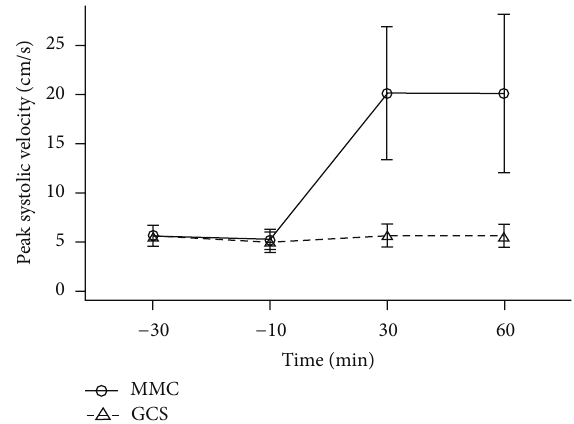
Figure 4: Peak systolic velocity measured in the popliteal vein at 30 and 10 minutes prior to the application of the GCS and MMC interventions and 30 and 60 minutes following their